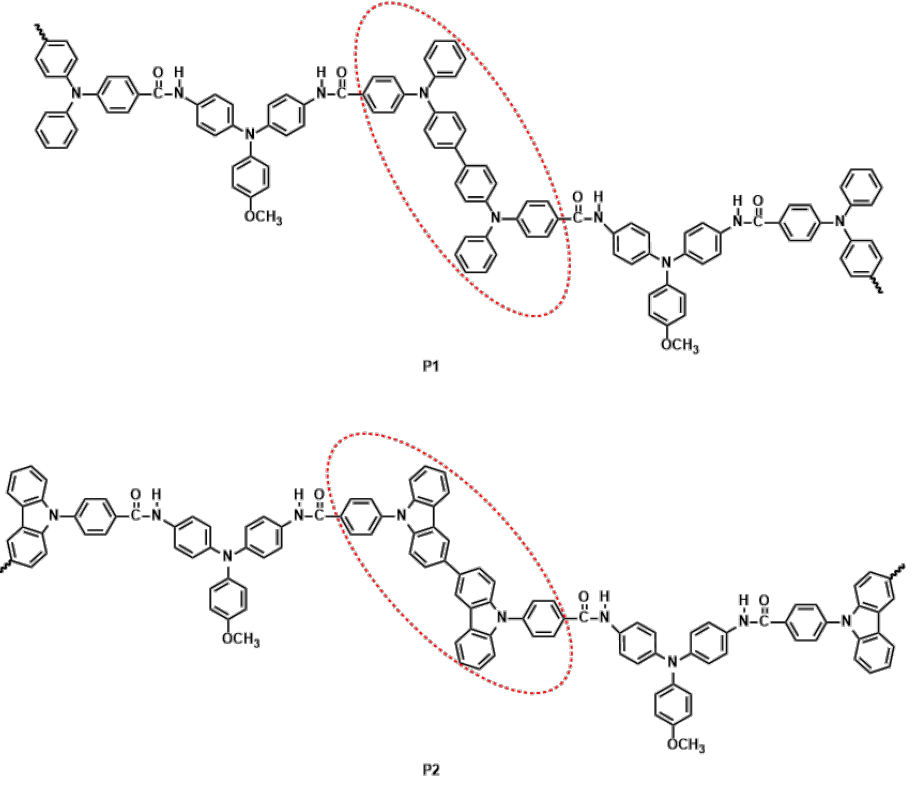
Scheme 2. Proposed structures of electro-generated polymers P1 and P2.